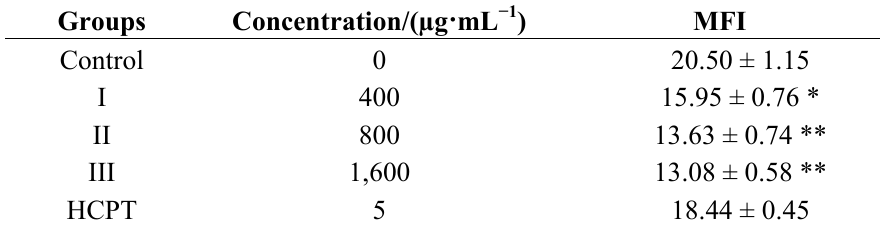
Table 3. Effect of Laminaran on pH of LOVO cells by FCM